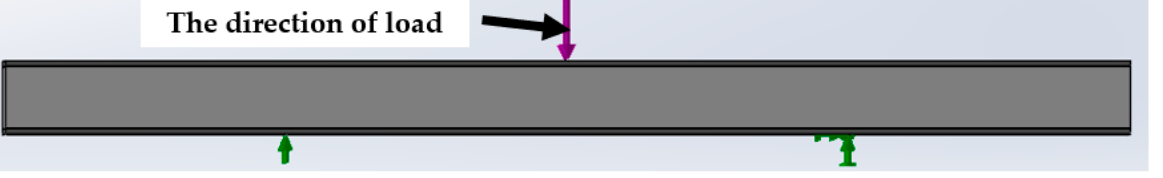
Figure 14. ( a ) The CAD model for the FE simulation of AFSS; ( b ) AFSS wrapped around four-layer CFRP (XPREG ® XC110 3K). Figure 15. Schematic of boundary conditions and load direction.